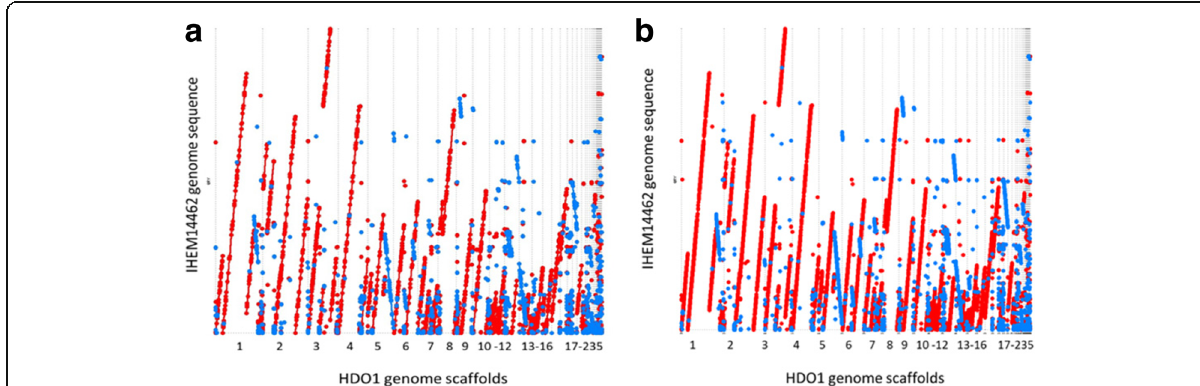
Fig. 5 Dot plot analysis comparing the HDO1 and IHEM14462 strains ’ genomes. a Comparison at the nucleotide level. b Comparison at the protein level. It shows the alignment of the genome sequence of IHEM 14462 strains (y axis) against HDO1 genome sequence (x axis). The red color lines and dots represent the forward matches between the both genome sequences while the blue color ones represent reverse matches